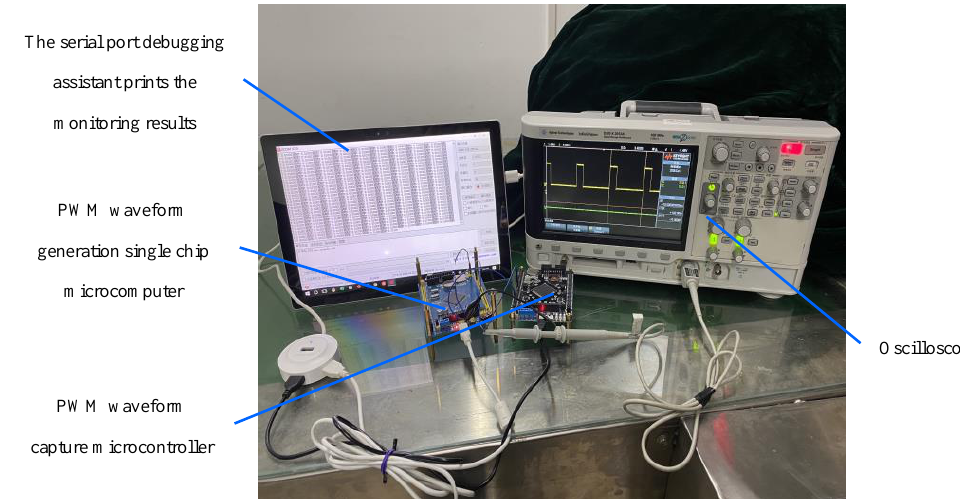
Figure 7. The verification test of the accuracy of the period time calculate algorithm.